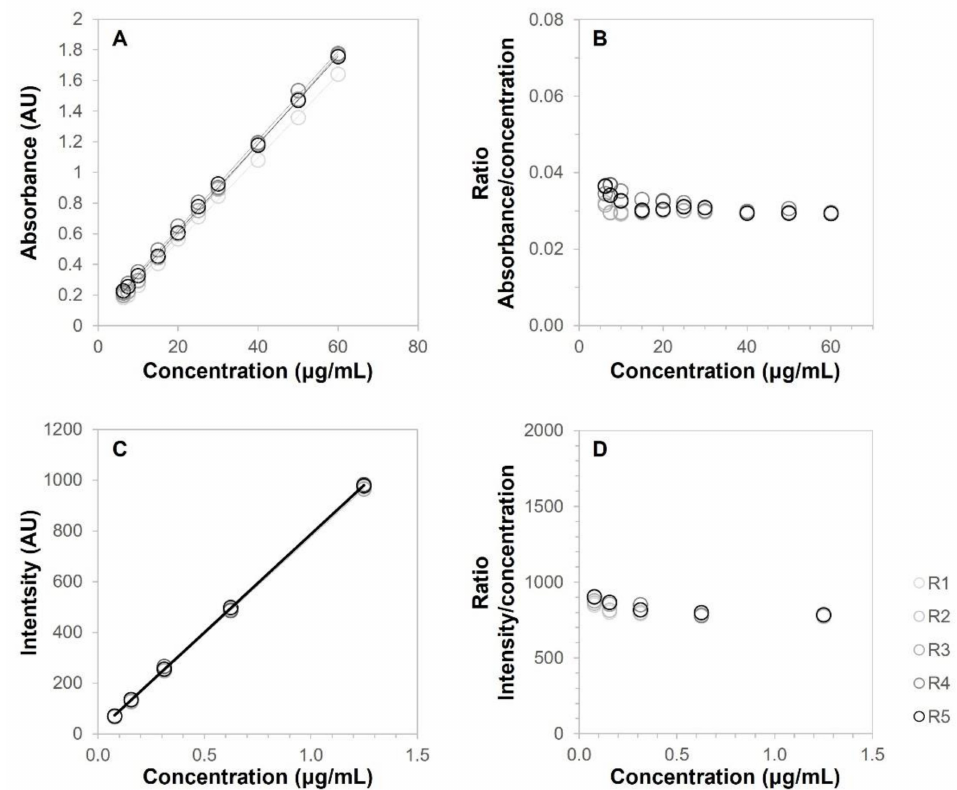
Figure 4. ( A ) Calibration curves of BCT in Transcutol ( n = 5) using absorption spectroscopy. ( B ) Response factor (ratio absorbance/concentration) using absorption spectroscopy. ( C ) Calibration curves of BCT in Transcutol ( n = 5) using fluorescence spectroscopy. ( D ) Response factor (ratio intensity/concentration) using fluorescence